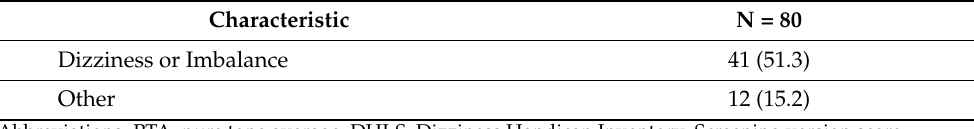
Table 1. Cont. Characteristic N = 80 Dizziness or Imbalance 41 (51.3) Other